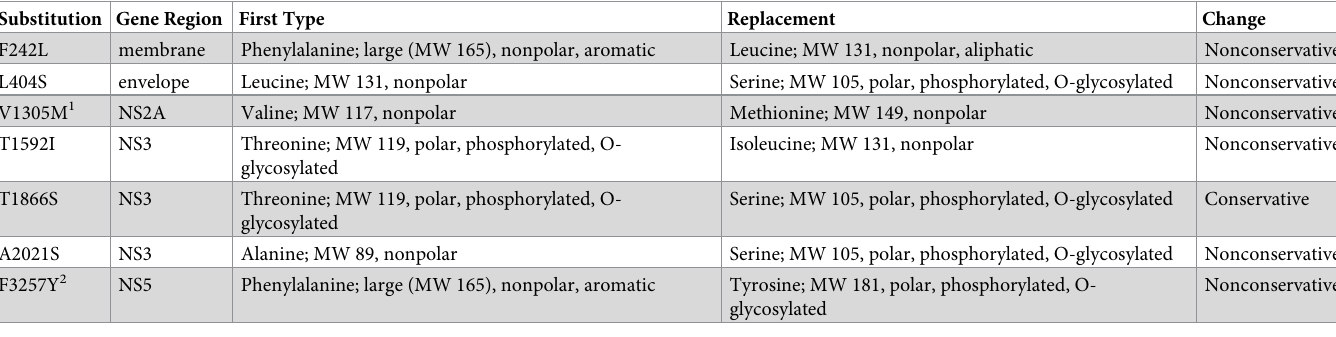
Table 3. Substitutions along the DENV-3 PNG lineage